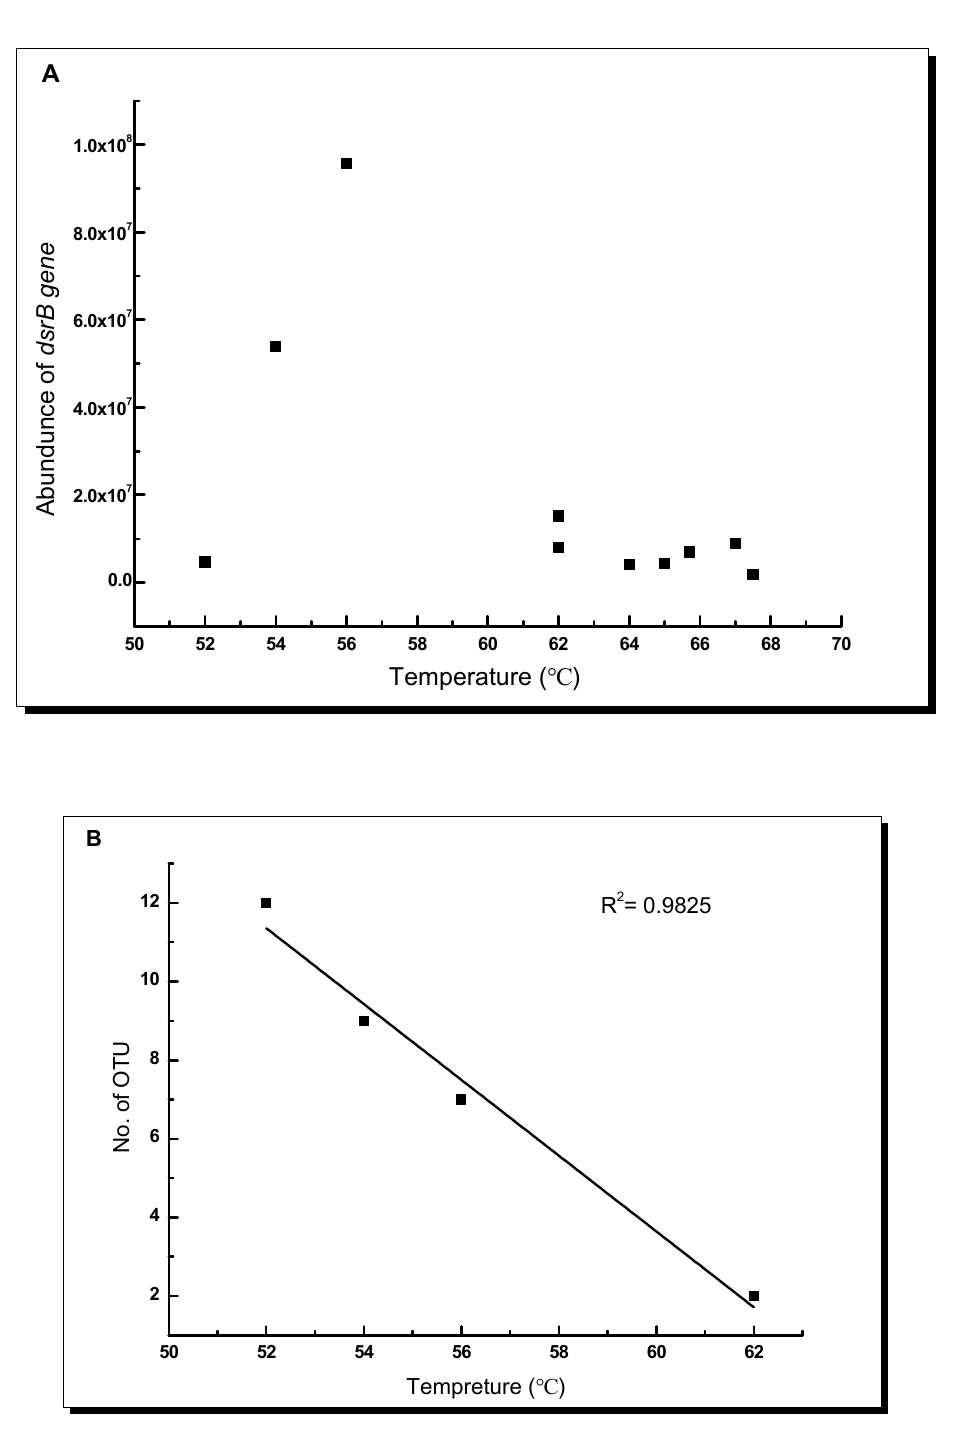
Figure 4. Correlations between temperature and the dsrB gene abundance of the studied Tibetan hot springs channel I and II ( A ); correlation between temperature and the number of identified dsrB gene operational taxonomic units (OTUs) in the samples along the channel I (i.e., Quzhuomu (QZM)-4, QZM-5, QZM-6, QZM-7) ( B